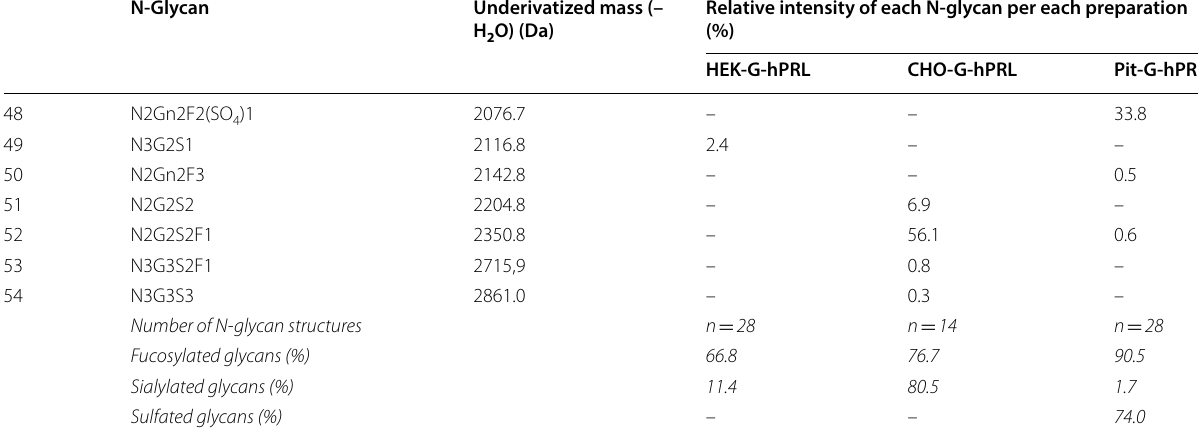
Table 2 Molecular mass of HEK cell-derived glycosylated prolactin obtained via N-glycoprofiling analysis and compared to MALDI–TOF-MS determination